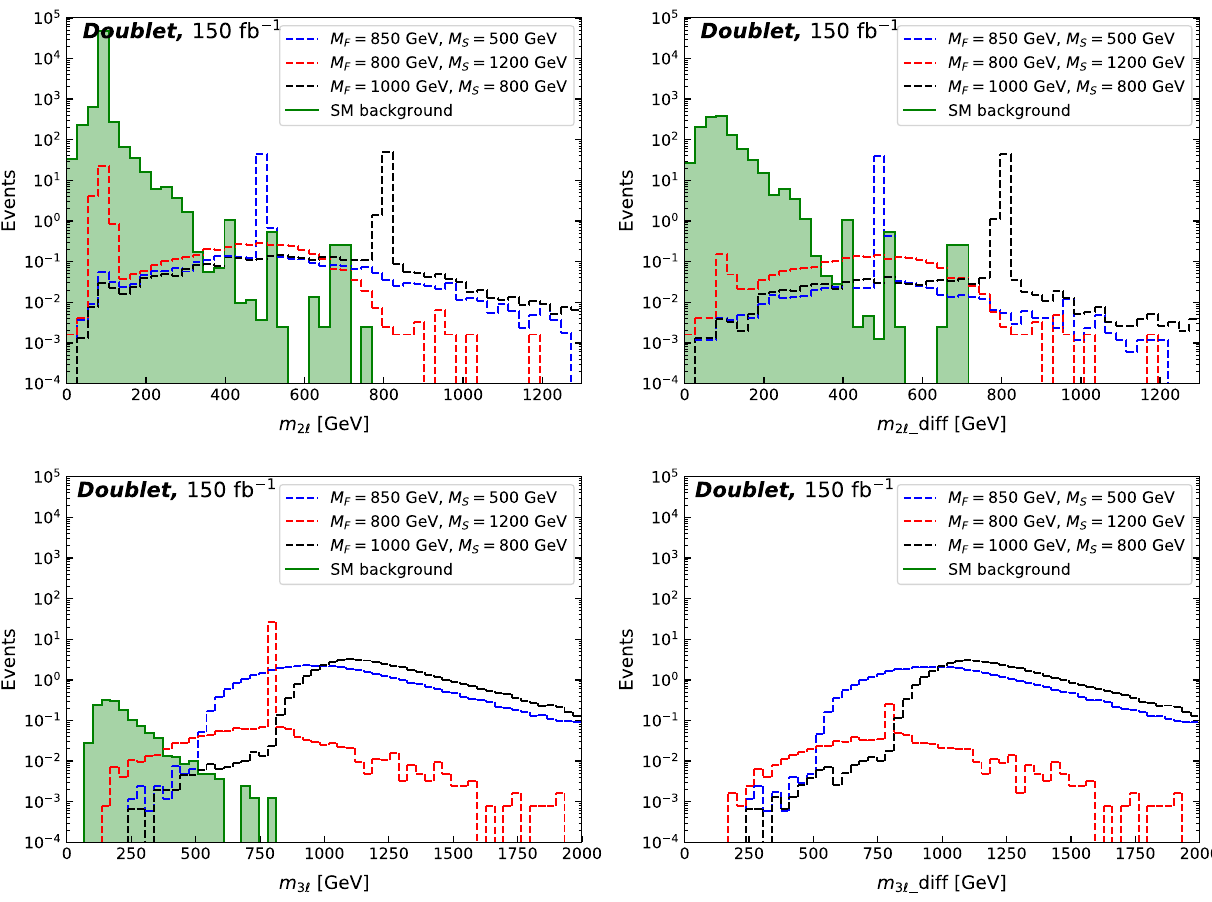
Fig. 9 Di- and trilepton invariant mass distributions m 2 (cid:5) , m 2 (cid:5) _diff, m 3 (cid:5) , and m 3 (cid:5) _diff (see Sect. 6 for details) for the doublet model for different benchmark masses of the VLLs and the BSM scalars at a luminosity of 150 fb − 1 and